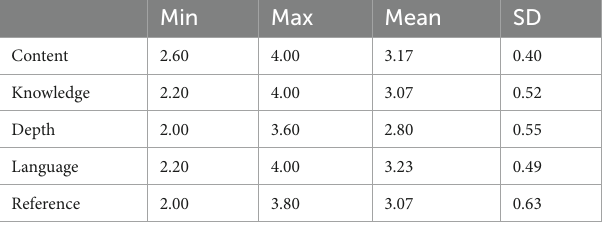
TABLE 4 Academic writing post-test mean and